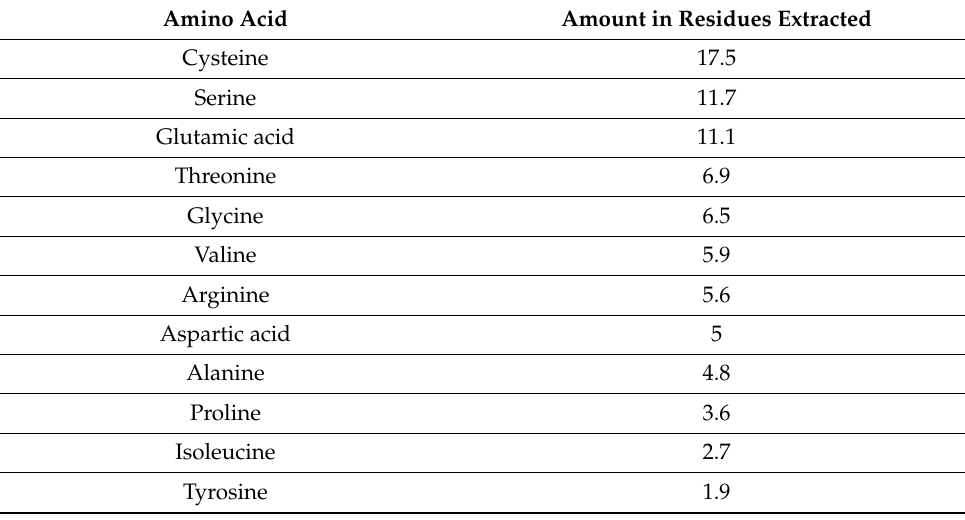
Table 9. Amino acids present in normal human hair [96].